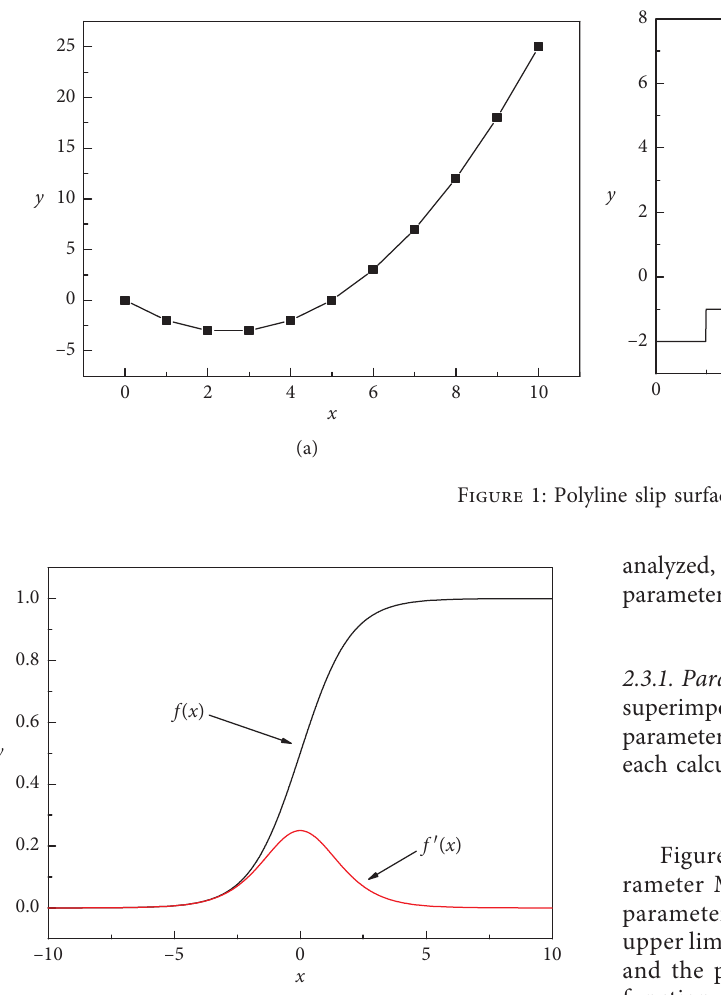
Figure 2: Logistic function and its derivative function.